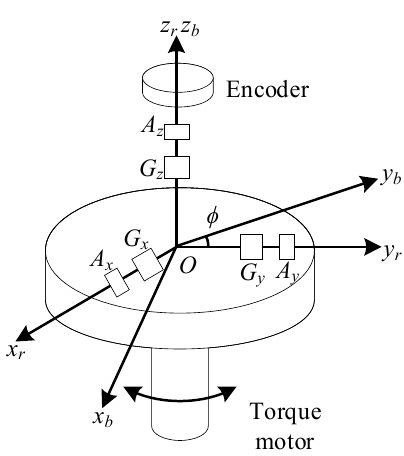
Figure 2. The structure of single-axis RINS.